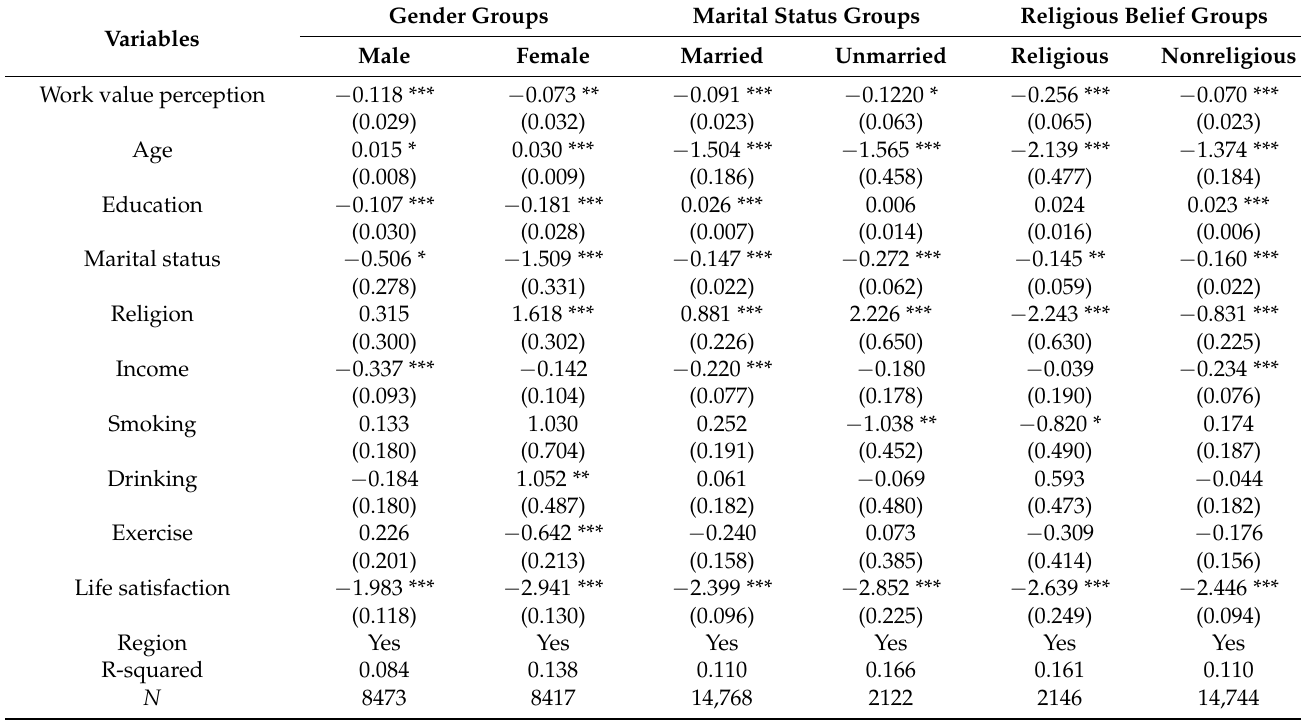
Table 7. Impacts of work value perception on workers’ mental health among different subgroups (IV − 2 SLS).